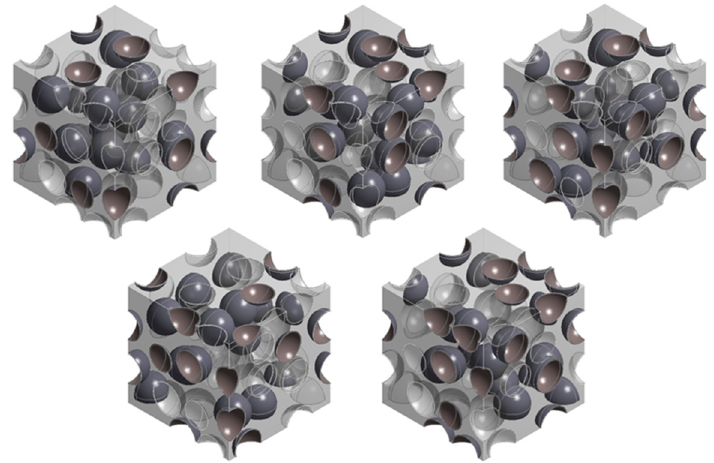
Figure 4. Five different representative elementary volumes (RVEs) for the mixed model, having the same ξ = 50% with differently selected debonded microspheres. In the figure, bonded microspheres are shown in dark grey and debonded microspheres are transparent.